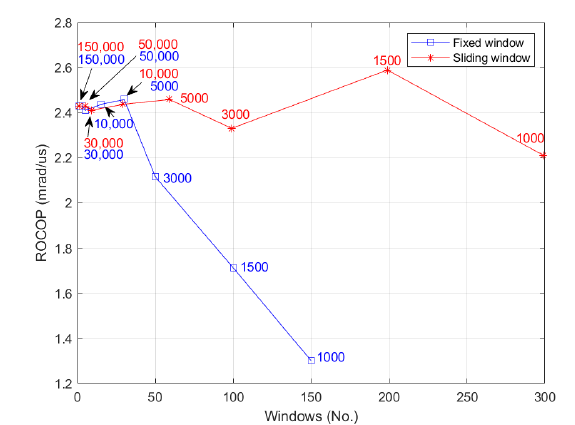
Figure 17. Maximum ROCOP values for different signal